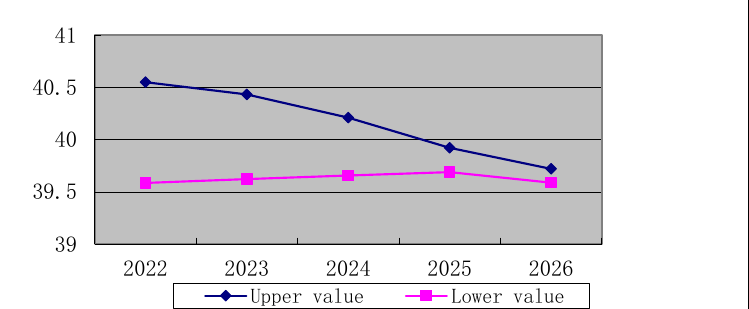
Figure 2. The variation interval of water requirement with the influence of primary industry in Beijing.